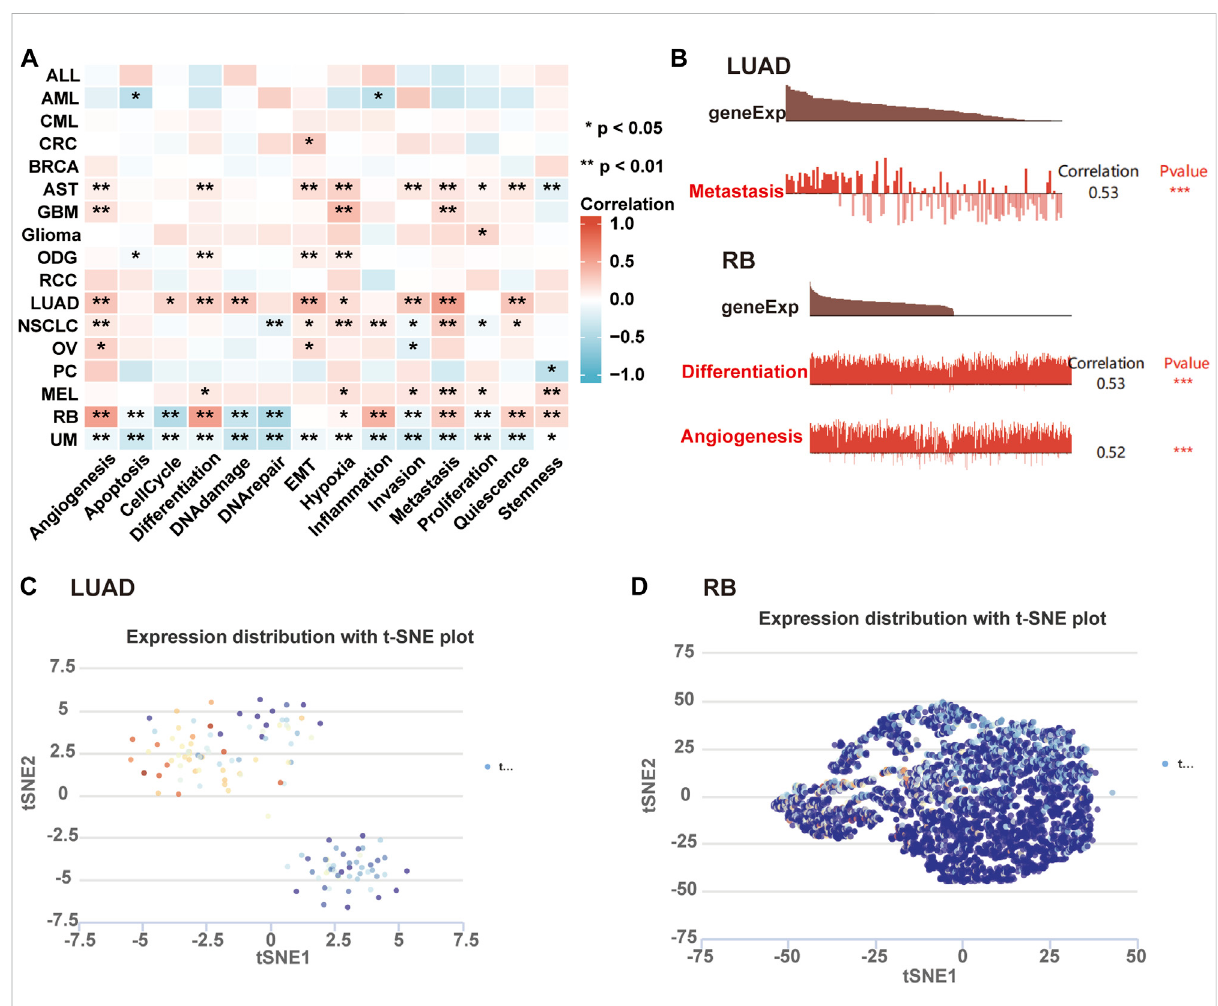
FIGURE 8 ExpressionpatternofAKAP12insingle-cellsequencinganditsrelationtotumorfunctionalstatus. (A) Heatmaprepresentationofthecorrelation of AKAP12 expression and distinct tumor functional states based on CancerSEA (* p < 0.05; ** p < 0.01; *** p < 0.001). (B) Association between the expression of AKAP12 and three signi fi cantly different functional states (*** p < 0.001). T-SNE diagram illustratedAKAP12 expression pro fi les in single cells of LUAD (C) and RB (D) samples,